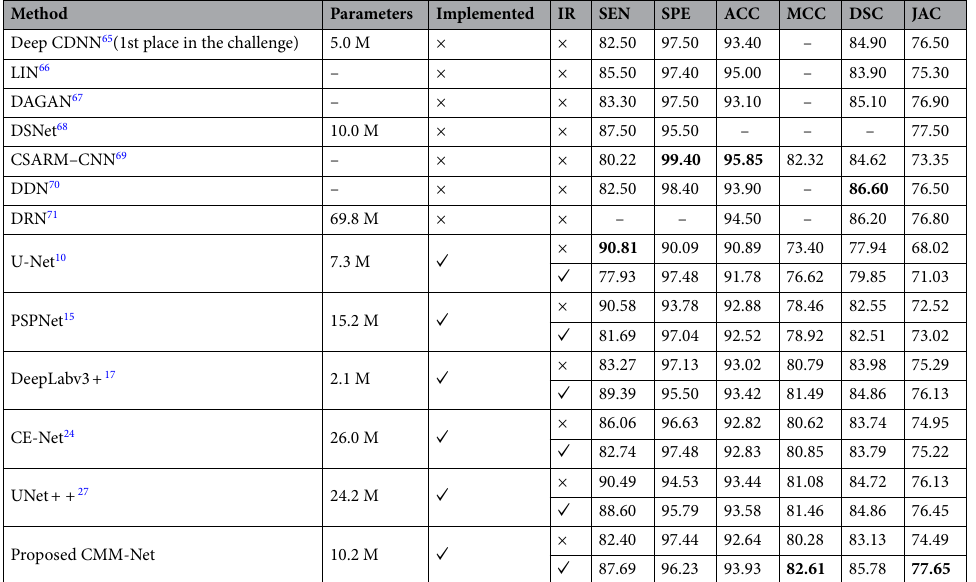
Table 3. Skin lesions segmentation performances (%) via the proposed CMM-Net compared to the recent deep learning approaches. CDNN: Convolutional-Deconvolutional Neural Networks; LIN: Lesion Indexing Network; DAGAN: Decision Augmented Generative Adversarial Networks; DSN: Dermoscopic Skin Network; CSARM-CNN: Channel & Spatial Attention Residual Module; DDN: Dense Deconvolutional Network; and DRN: Dense-Residual Network. The results of U-Net are different from those presented in Table 2 (i.e., first row) because the network was trained using the augmented training data similar to other methods in this table.